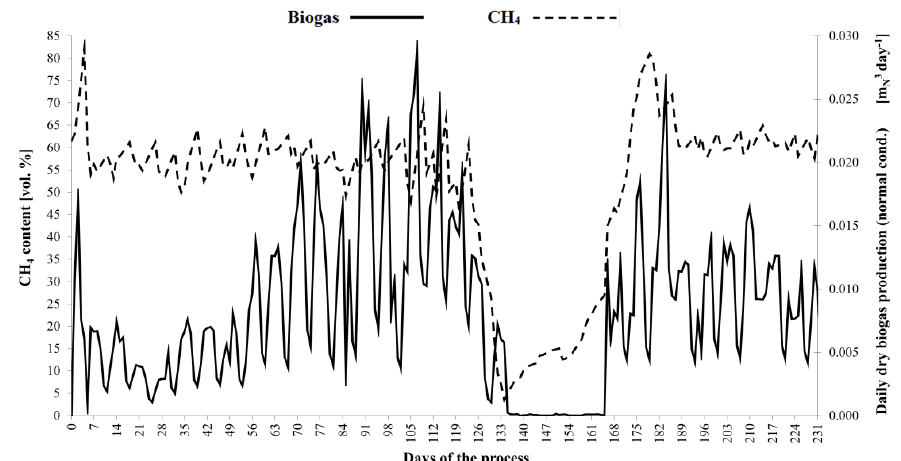
Figure 4. Biogas production and its CH 4 content.